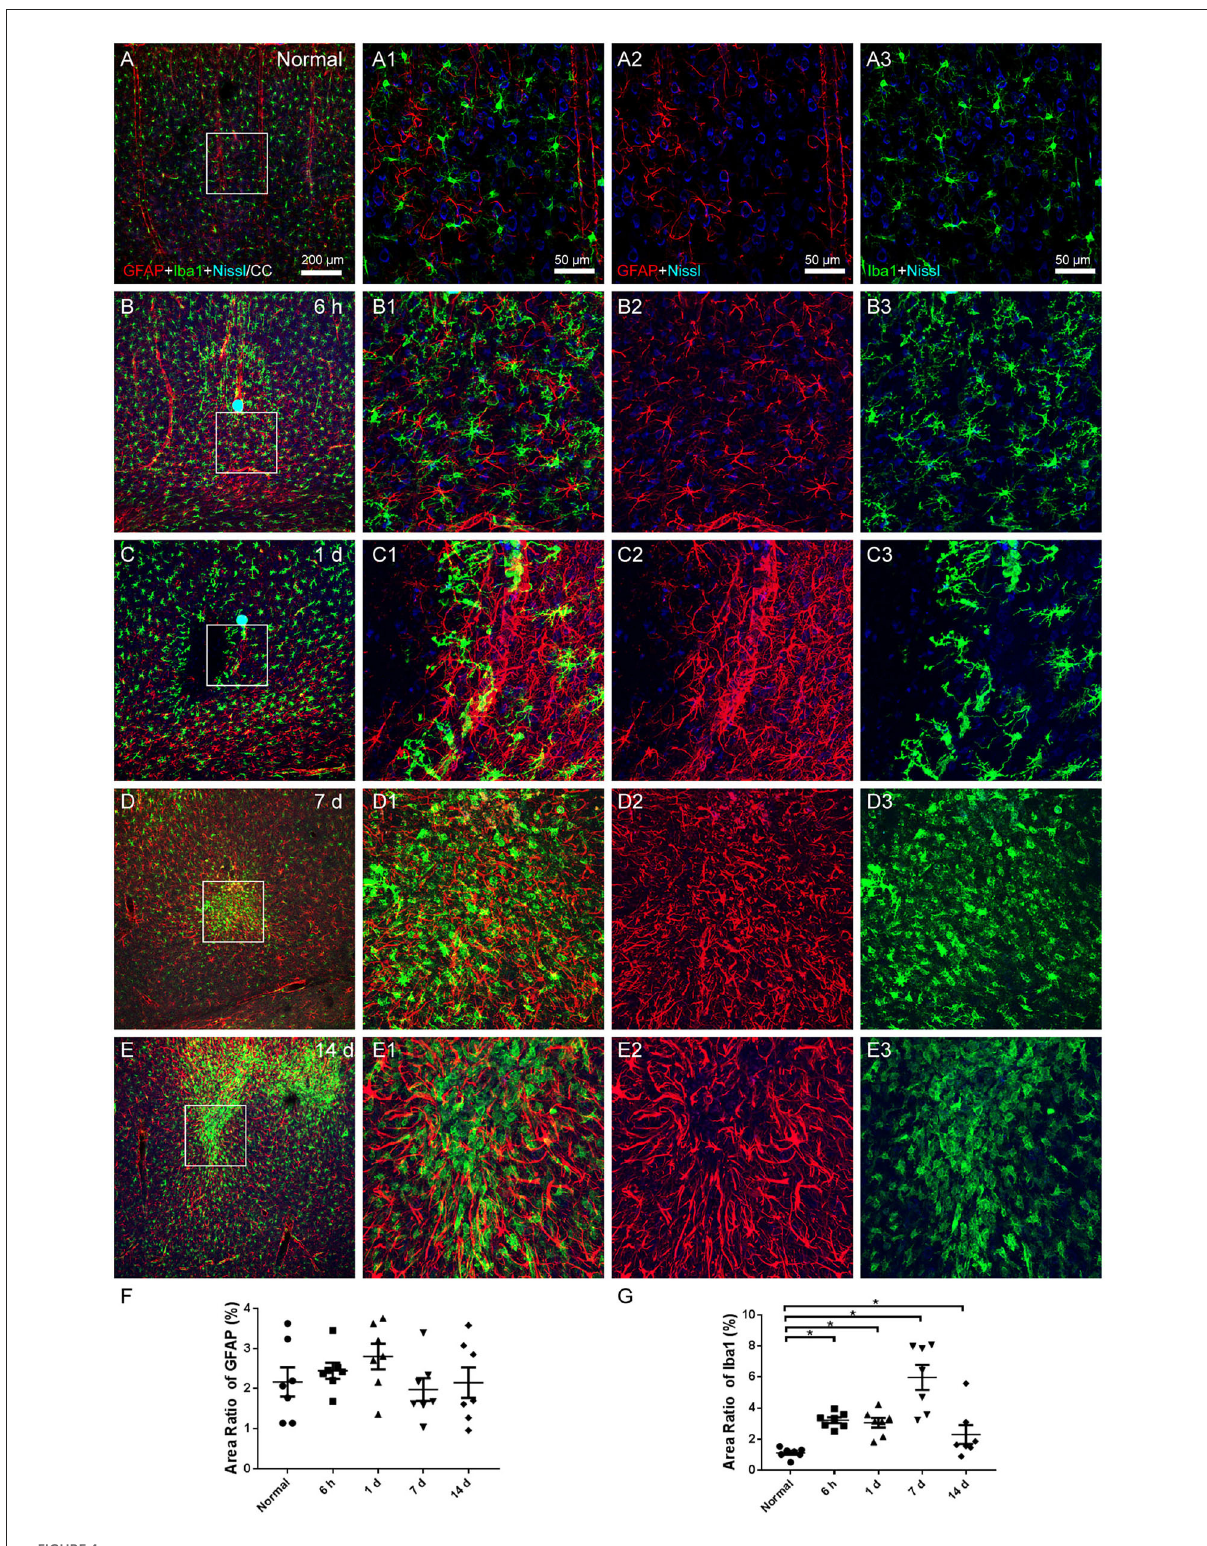
FIGURE4 The astroglial and microglial alteration in the cerebral cortex. (A–E) The representative photographs from the cerebral cortex at the group of normal, 6h, 1, 7, and 14 days, showing GFAP (red, Alexa Fluor 594)-labeled astrocytes, Iba1 (green, Alexa Fluor 488)-labeled